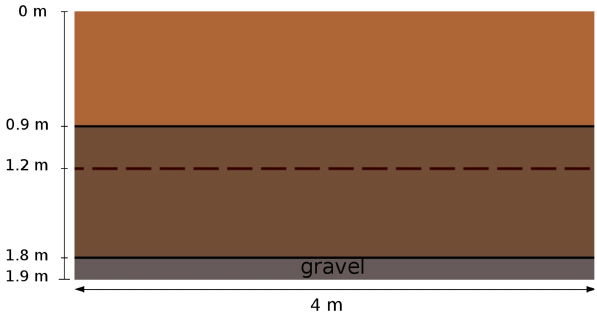
Fig. 1. Sketch of geometry of interest shown in vertical cross- section: two different sand layers plus another compaction horizon (dashed